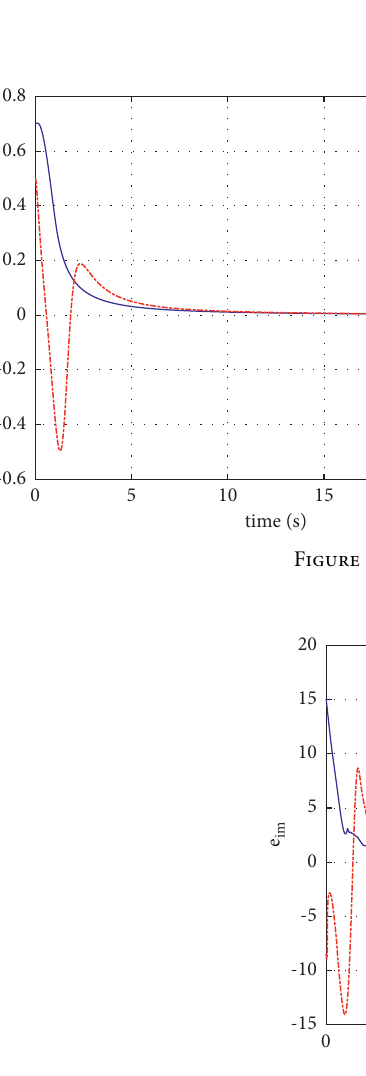
Figure 3: Performances of the impedance